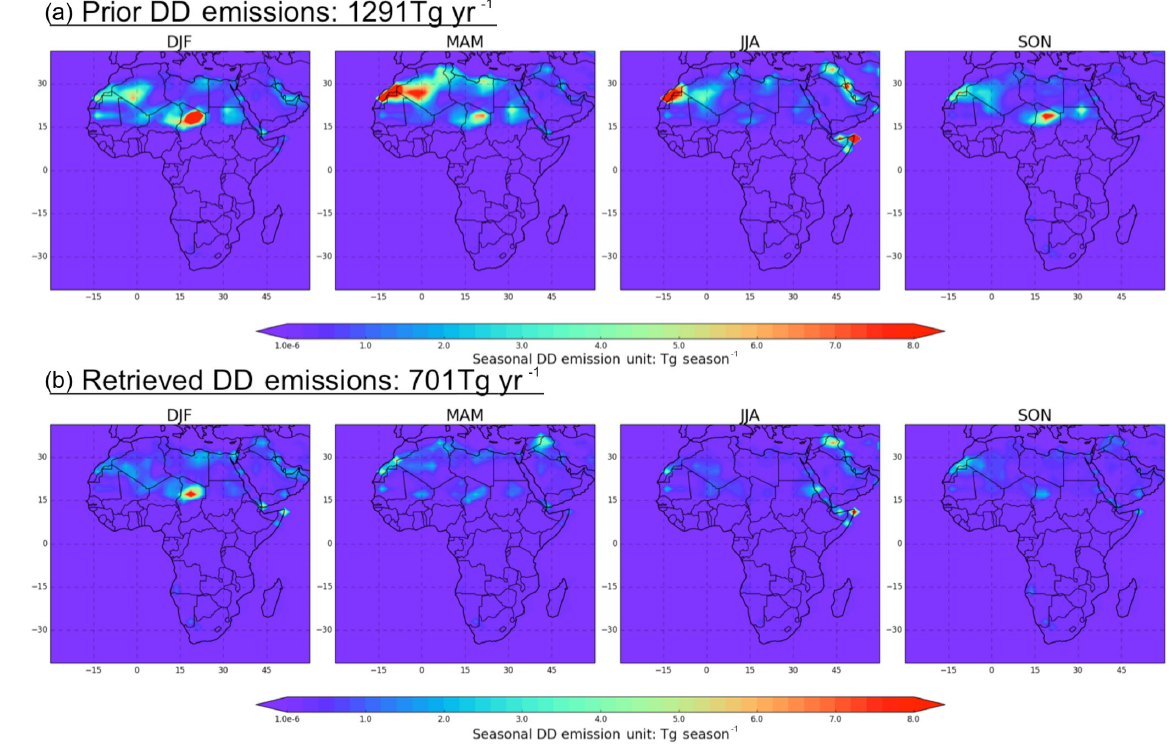
Figure 14. Spatial distribution of seasonal desert dust aerosol emissions: (a) “prior model” DD emissions from DEAD model and (b) retrieved DD